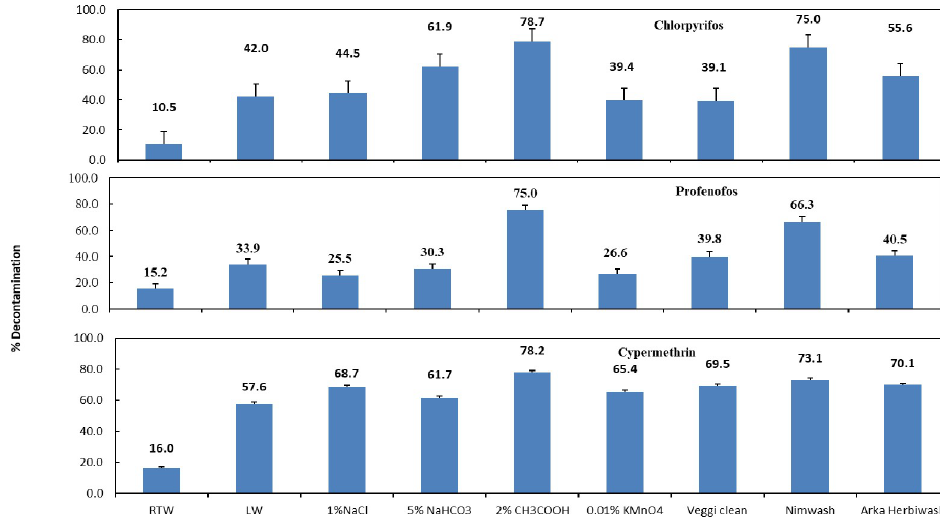
Fig 2. Effect of different decontamination treatments on % removal of pesticides analyzed by GC-ECD on okra. The vertical bars indicate critical difference at P � 0.05. The numerical values against histograms indicate percent (%) decontamination of pesticide